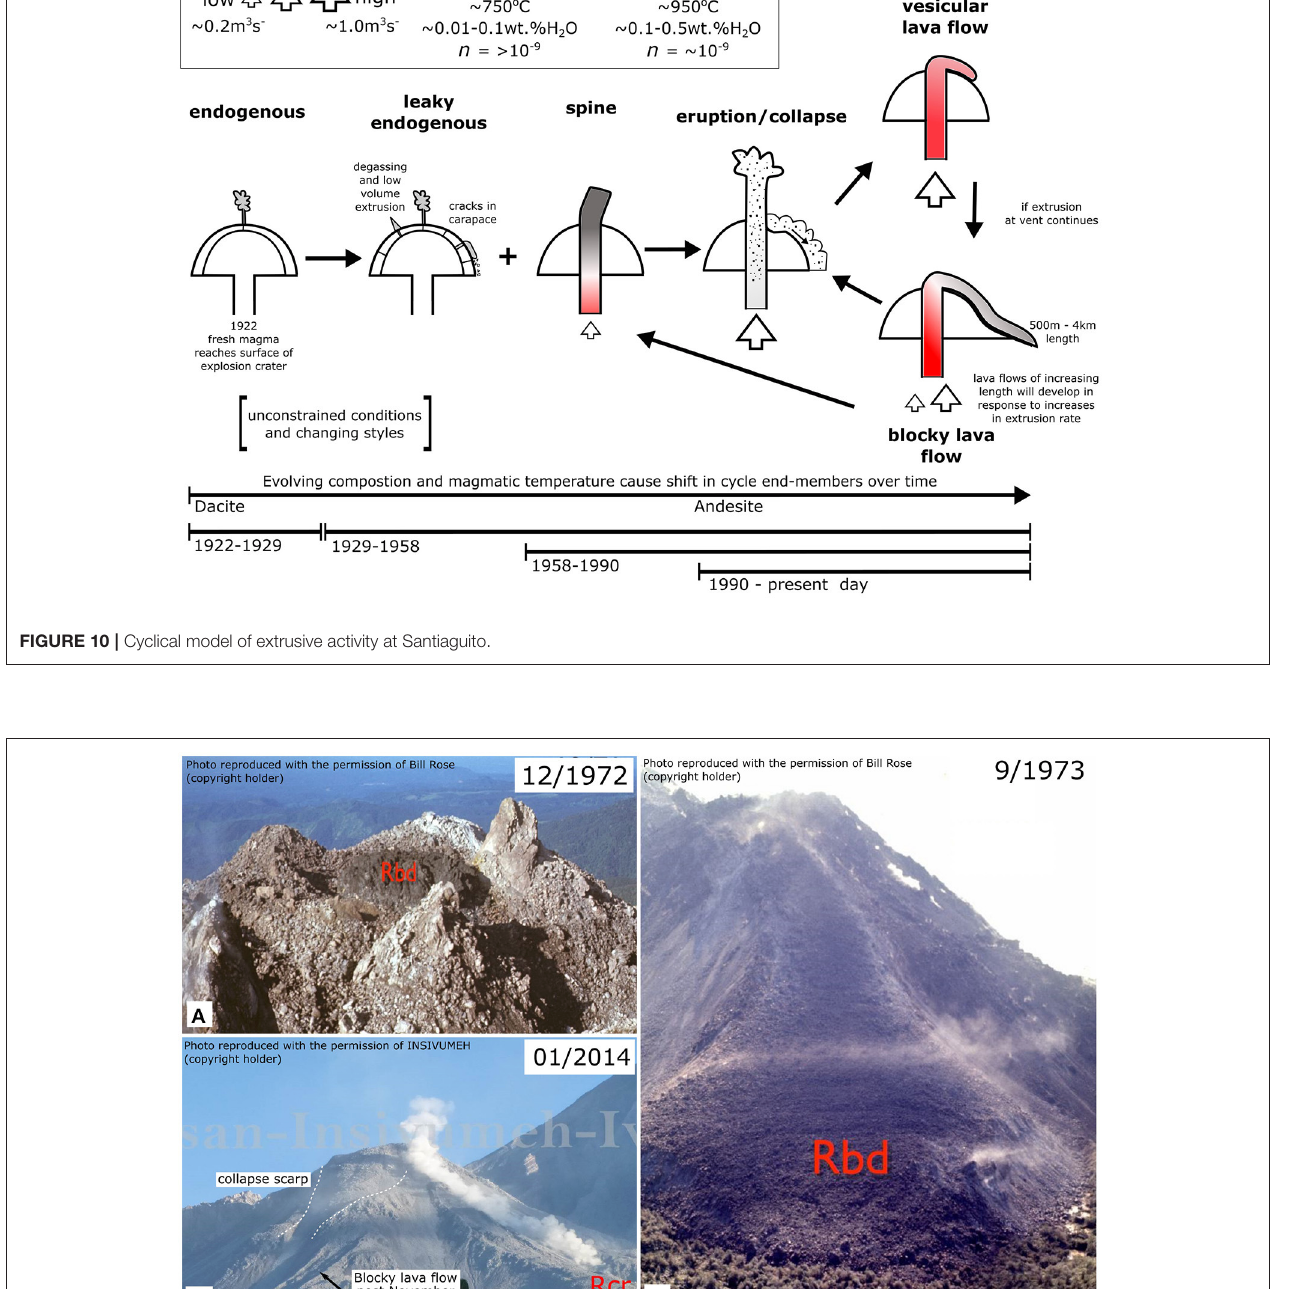
Frontiers in Earth Science | www.frontiersin.org